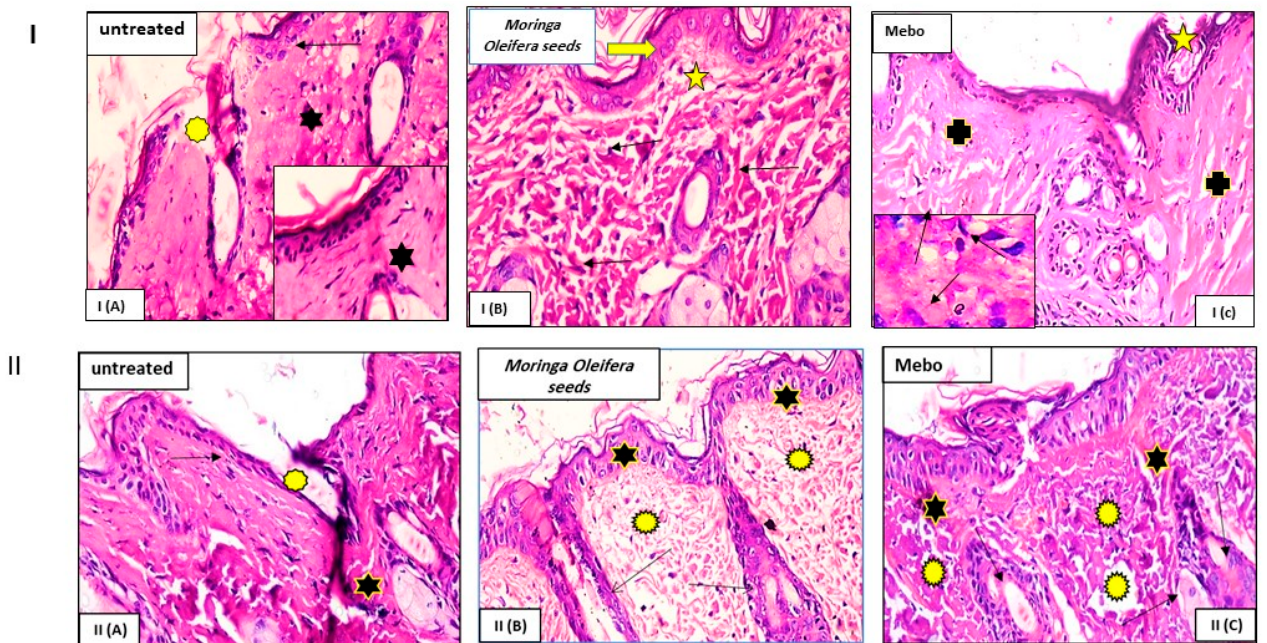
Figure 3. Wounded skin 7 (I-top) and 14 days (II-down) after incision. ( I ) Group I ( A ) (untreated): Showing a normal edged wound with normal epidermis (arrow). The wound is packed with blood clots (asterisk), which are highlighted by sloughed granulation tissue and dense uneven collagen bundles (star). Group I ( B ) ( Moringa oleifera seeds extract) exhibited significant re-epithelization (thick arrow). The granulation tissue filling the defect’s base (from below) is mostly cellular (star). Collagen bundles manifested as disordered coarse and wavy bundles (arrows). Group I ( C ) (MEBO ® ): Scar tissue obstructing the wound (star). Collagen bundles form a reticular pattern around the defect, similar to that of the nearby normal dermis (crosses). The inset depicts inflammatory cellular infiltration, primarily of macrophages (black arrows). ( II ) Group II ( A ) (left untreated): Wide wound area (stars) with substantial inflammatory cellular infiltration in an acidophilic matrix (asterisks) and normal skin (arrows). Group II ( B ) ( Moringa oleifera seeds extract): Typical stratified squamous keratinized epithelium (stars) and dermal matrix with coarse wavy collagen bundles pointing in various directions (asterisks). The freshly created hair follicles (arrows). Group II ( C ) (MEBO ® ): Typical epithelium, thin scar tissue extending into the dermis (stars), and reticular dermis with coarse wavy collagen bundles organized in different orientations are all visible (asterisks), and newly formed hair follicles (arrows). (Hx and E stain × 200 and 400).